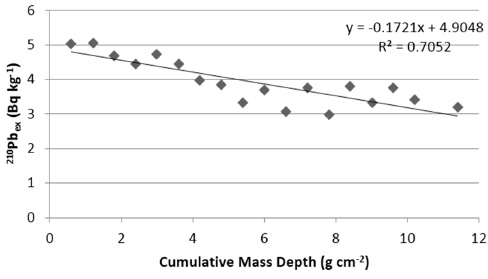
Figure 4. 210 Pb ex activity concentrations on a logarithmic scale (ln) versus cumulative mass depth. Table 4. Vertical distribution of 210 Pb in dated layers.